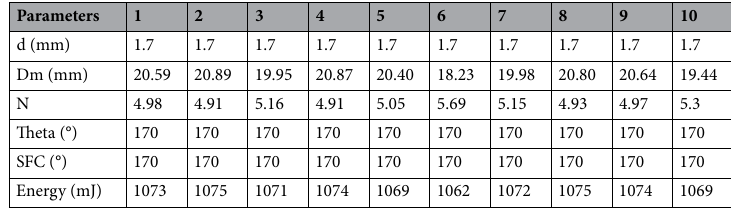
Table 3. Optimization results for torsion spring—Scenario 1.